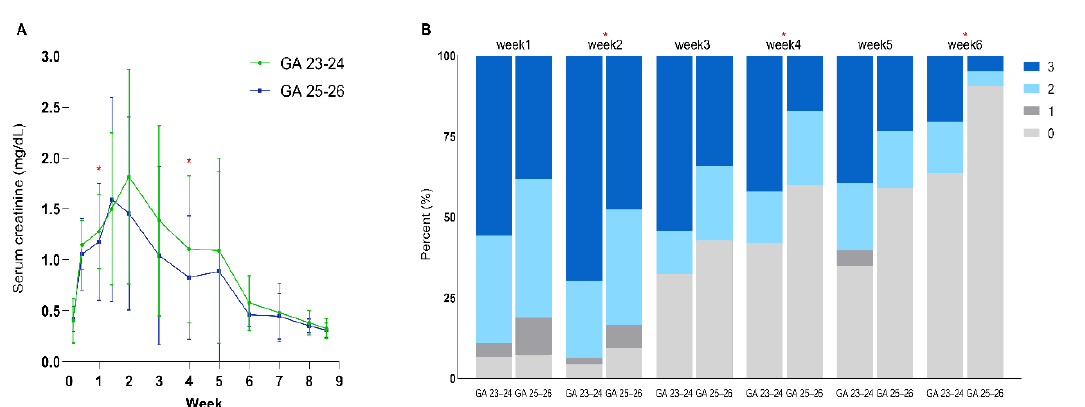
Figure 1. Time course of the mean serum creatinine levels within di ff erent gestational groups and prevalence of acute kidney injury (AKI) by stage in a week interval. ( A ) Serum creatinine profile for the 6 weeks of life in accordance to di ff erent gestational age groups; ( B ) Prevalence of AKI by stage in a week interval. * p < 0.05 in comparison between infants at 23–24 and those at 25–26 weeks of gestation.